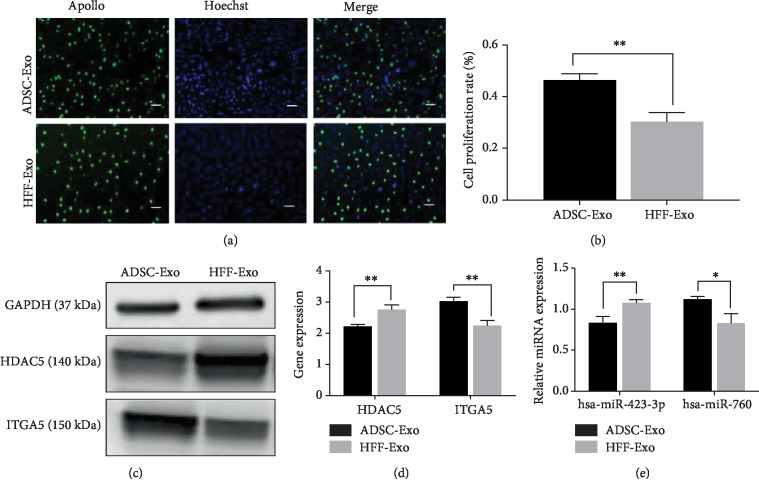
ADSC-Exo promote HUVEC proliferation and regulate expression of related genes. (a) Proliferating HUVECs were stained with green fluorescence, and all nuclei were stained with blue fluorescence. (b) Comparison of cell proliferation rates between the ADSC-Exo group and HFF-Exo. Scale bars indicate 100 μm. (c and d) The expression levels of ITGA5 and HDAC5 genes in HUVECs treated with ADSC-Exo or HFF-Exo. (e) The relative miRNA expression levels of hsa-miR-423-3p and hsa-miR-760 in HUVECs treated with ADSC-Exo or HFF-Exo. ∗P < 0.05 and ∗∗P < 0.01.